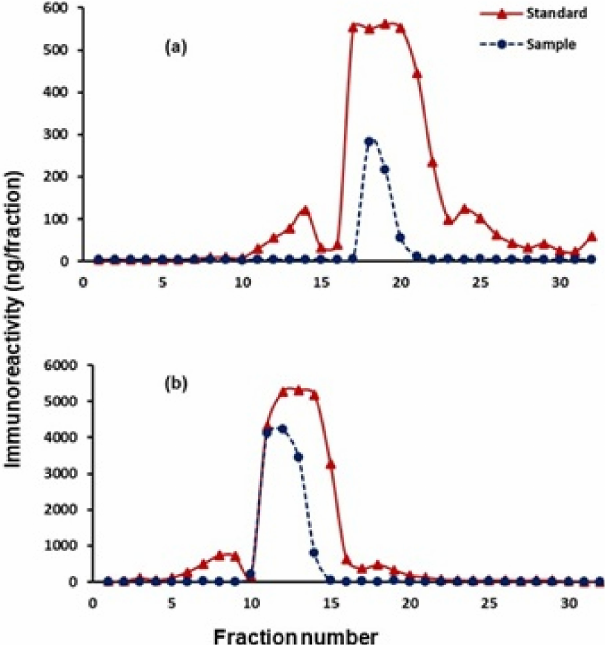
Figure 2. HPLC profiles of immunoreactive fecal progesterone ( a ) and testosterone ( b ) in pygmy